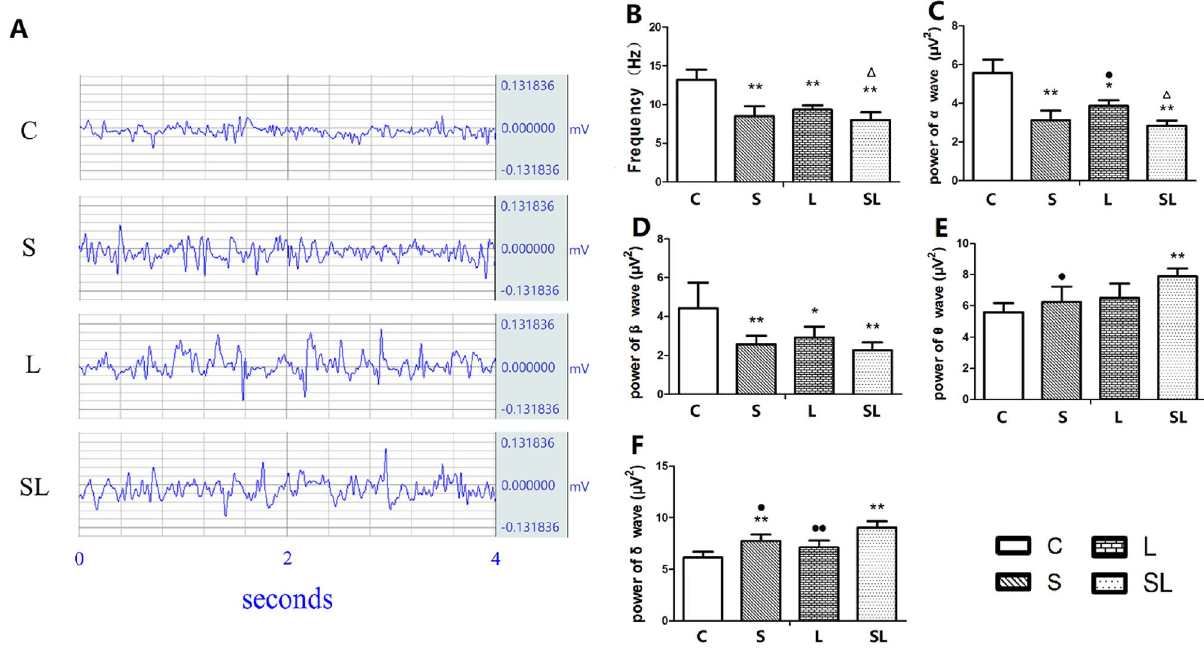
Figure 2. Changes in the frequency and power of α, β, θ and δ waves in the EEGs. The data are presented as the means ± SDs. ( A ) shows the waveforms of the EEGs in the four groups. ( B ) shows the statistical results of the EEG frequency. (C)-(F) show the statistical results of the powers of α, β, θ and δ waves, respectively. * p < 0.05 and ** p < 0.01 compared to the C group. 1. • p < 0.05 and •• p < 0.01 compared to the cumulative group. Δ p < 0.05 indicates the existence of interaction effects between the 2.856 GHz and 1.5 GHz microwaves. “C” stands for the control group, “S” stands for the 2.856 GHz microwave exposure group, “L” stands for the 1.5 GHz microwave exposure group, and “SL” stands for the 2.856 and 1.5 GHz cumulative exposure